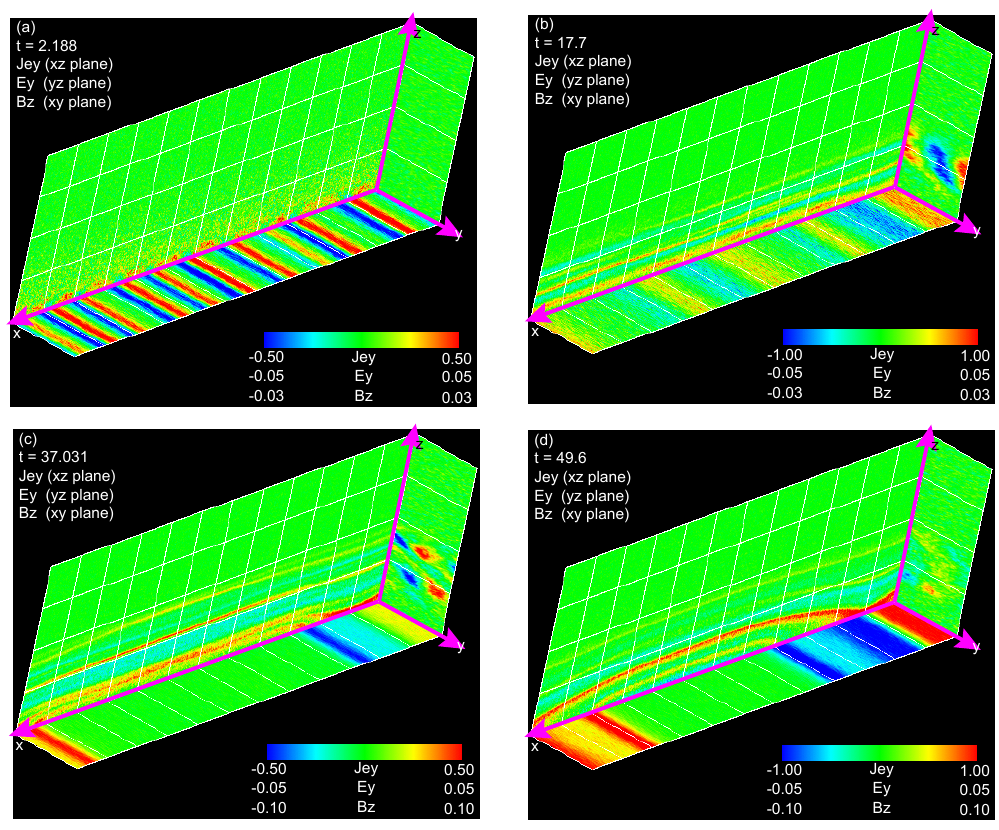
Figure 3 Fig. 3. 3-D snapshots from the α io =1, α eo =2, and D =1.125 case. (a) t =2.188, (b) 17.7, (c) 37.1, and (d) 49.6. Color contours on the XY, YZ, and XZ planes are for B z , E y , and j ey , respectively. The displayed domain is 0 <x< 12 D , 0 <y< 1, and 0 <z< 4 D . In order to see the y-directional structure easily, elongation by a factor of 4 in the y-direction is applied. See text for details.